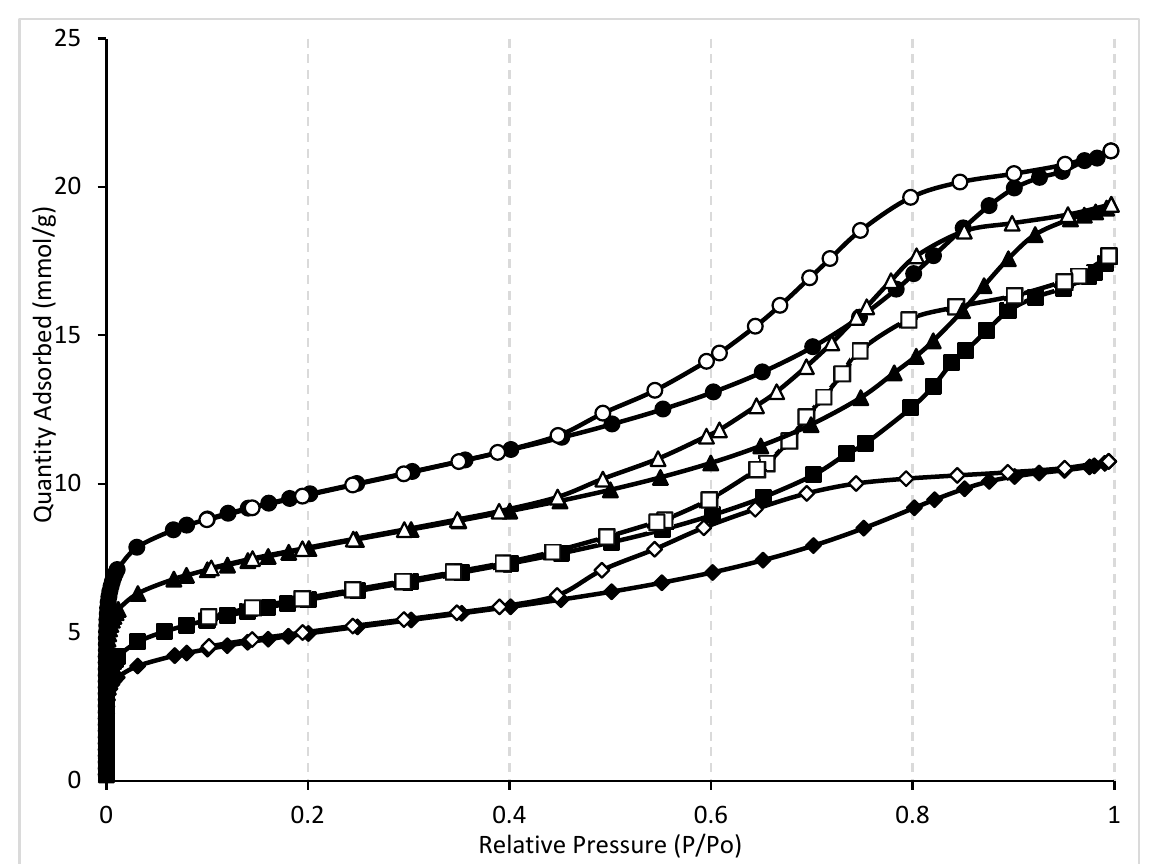
Figure 2. N 2 -adsorption–desorption isotherms measured at 77 K. for the catalysts Au@meso-UiO- 66-before- ( ● ) and -after-( ▲ ) catalysis nanohybrids; Au@meso-NH 2 -UiO - 66-before- ( ■ ) and -after- catalysis nanohybrids ( ♦ ). (solid symbols—adsorption, open symbols—desorption). Table 1. Textural characteristics for the meso-UiO-66 and meso-NH 2 -UiO-66 matrices as well